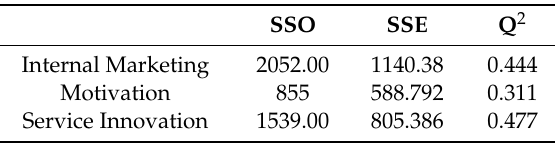
Table 8. Relevance Q2.